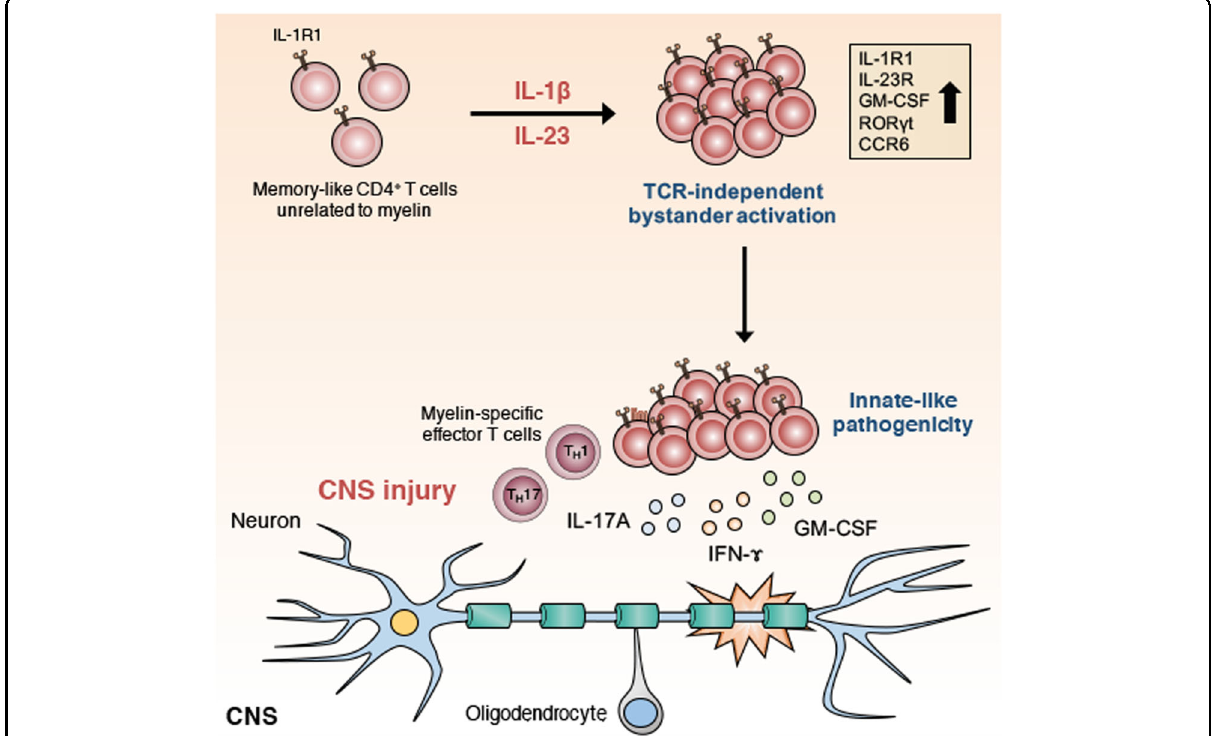
Fig. 3 IL-1 β and IL-23 induce pathogenic function in bystander-activated memory-like CD4 + T cells in autoimmune neuroin fl ammation. IL- 1 β and IL-23 induce innate-like pathogenic function in memory-like CD4 + T cells that are not speci fi c for myelin. Along with myelin-speci fi c effector T cells (T H 1 and T H 17), bystander memory-like CD4 + T cells contribute to the development of autoimmune pathogenesis by increasing IL-17A, IFN- γ , and GM-CSF levels in the CNS. Thus, bystander-activated memory-like CD4 + T cells responding to IL-1 β and IL-23 perform a pathogenic role in an antigen-independent manner in autoimmune encephalomyelitis. IL interleukin, IFN- γ interferon- γ , GM-CSF granulocyte-macrophage colony- stimulation factor, IL-1R1 interleukin-1 receptor type 1, IL-23R interleukin-23 receptor, ROR γ t RAR-related orphan receptor gamma, CCR6 chemokine receptor 6, T H 1 T-helper 1, T H 17 T-helper 17, CNS central nervous